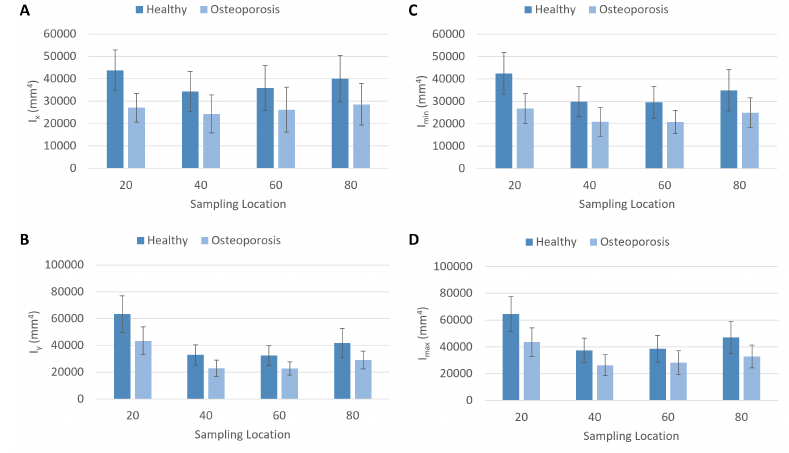
Figure 3. Plots of area moment of inertia data from the healthy and osteoporosis experimental groups. ( A ) Area moment of inertia around the x axis ( I x ) . ( B ) Area moment of inertia around the y axis ( I y ) . ( C ) Minimum area moment of inertia ( I min ) . ( D ) Maximum area moment of inertia ( I max ) . Sampling location = percentage of biomechanical length.